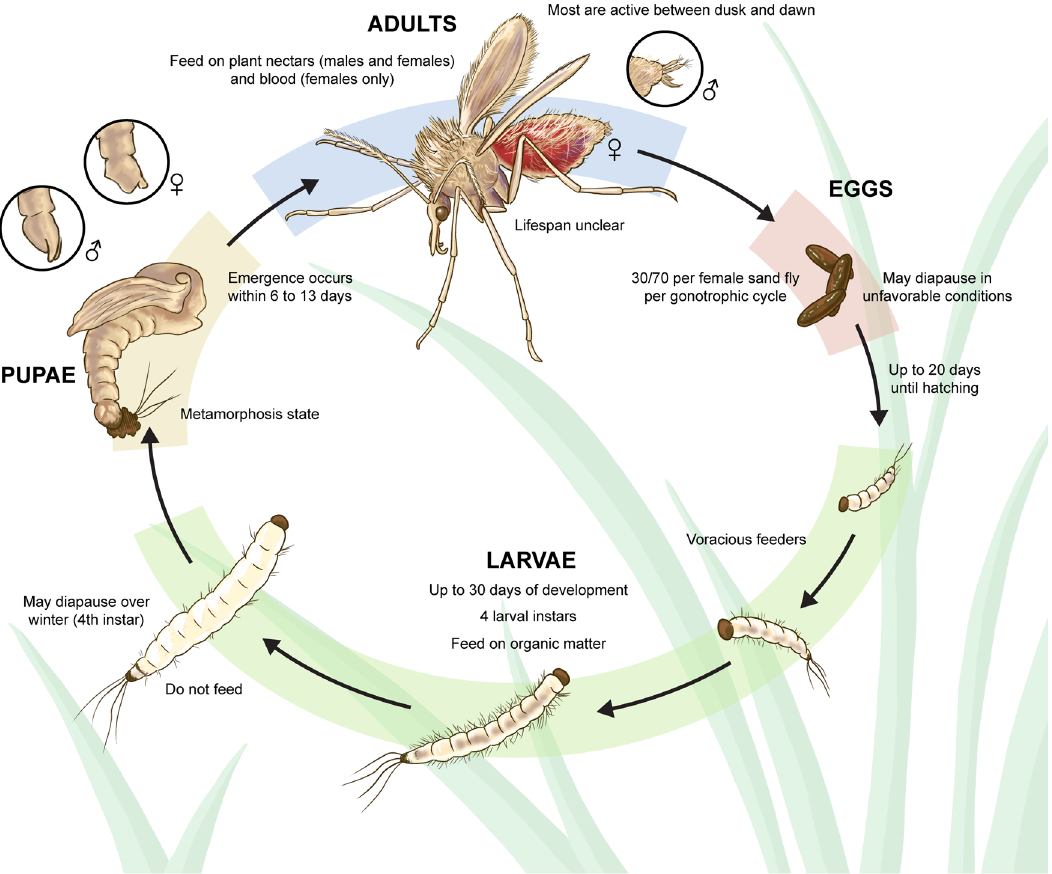
Fig. 2 Schematic representation of the sand fl ies ’ life cycle. The sand fl y life cycle comprises four major stages: eggs (orange background), larvae (four instars: green background), pupae (yellow background), and adults (blue background). In the latter two stages, different morphological features (highlighted within the circles) can be used to distinguish the gender. The most important characteristics with respect to each stage (sub-stage), are listed near the images, as are the average timings of development. Adapted from 7,130,131 . Courtesy